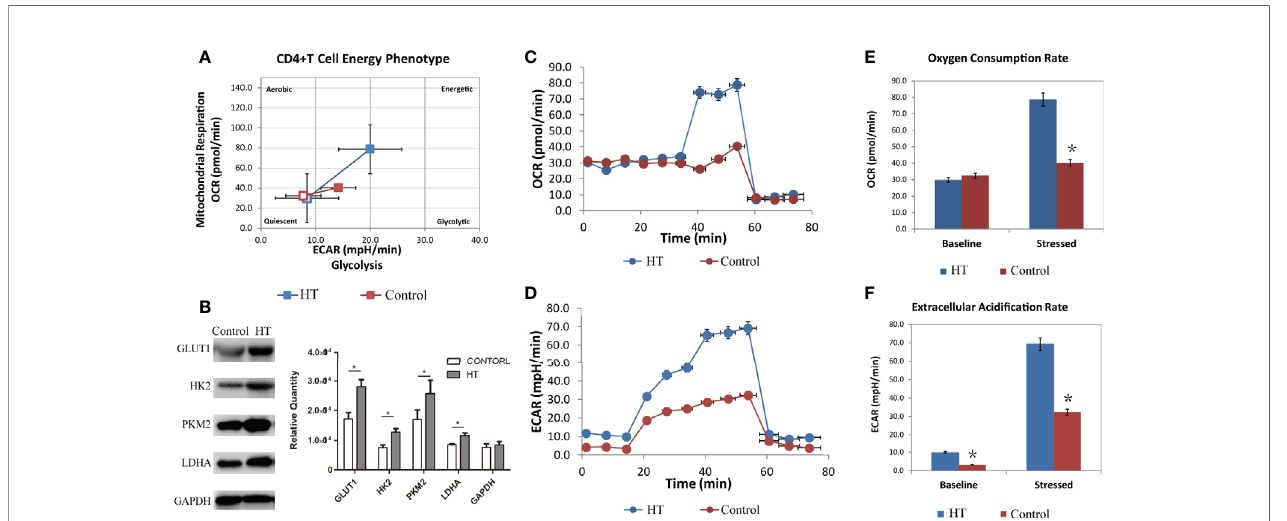
FIGURE 2 | The metabolism characteristic of CD4+ T cells from HT patients and HC group. The overall phenotype of CD4+ T cells (A) of HT patients (blue) and HC group (red). The hollow squares represent the basal ECAR (X-coordinate) and OCR (Y-coordinate), and the solid squares represent the stressed ECAR (X-coordinate) and OCR (Y-coordinate). Both basal OCR and stressed OCR of CD4+ T cells (C, E) and basal ECAR and stressed ECAR (D, F) in two groups were measured by seahorse after incubated with CD3/CD28 for 3 days. The expression of glycolysis related key enzyme (Glut1, HK2, PKM2 and LDHA) in cultured HT CD4+ T cells (B) were measured by western blot. ECAR, extracellular acidi fi cation rate. OCR, oxygen consumption rate. *P < 0.05.